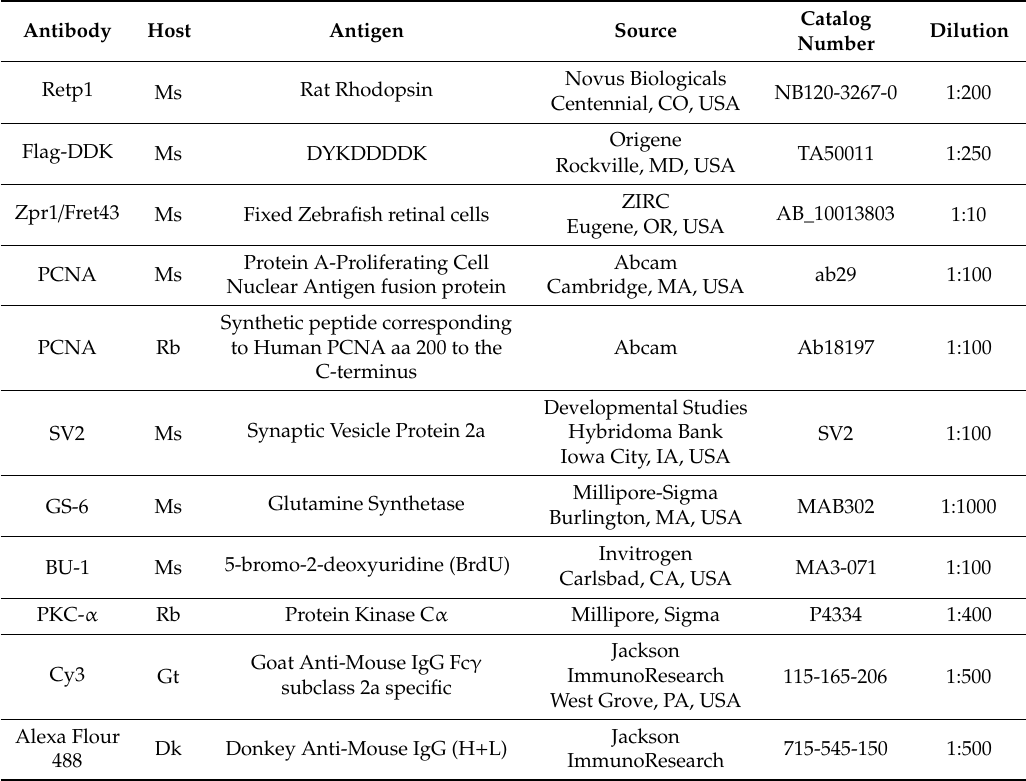
Table 1. List of antibodies used in this